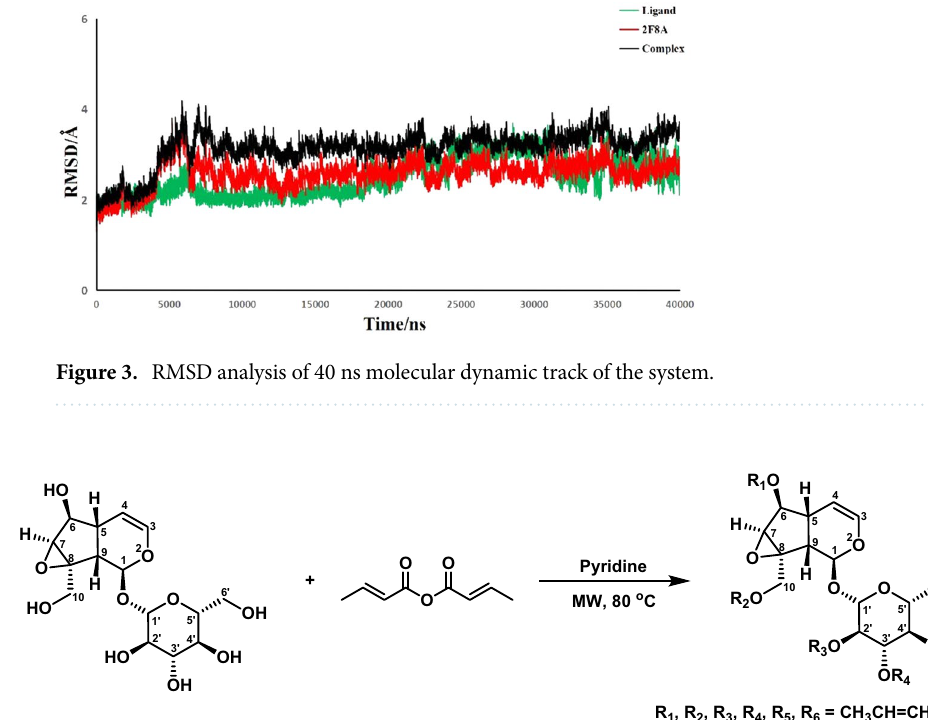
Scheme 1. MWAS synthetic route of CCs.